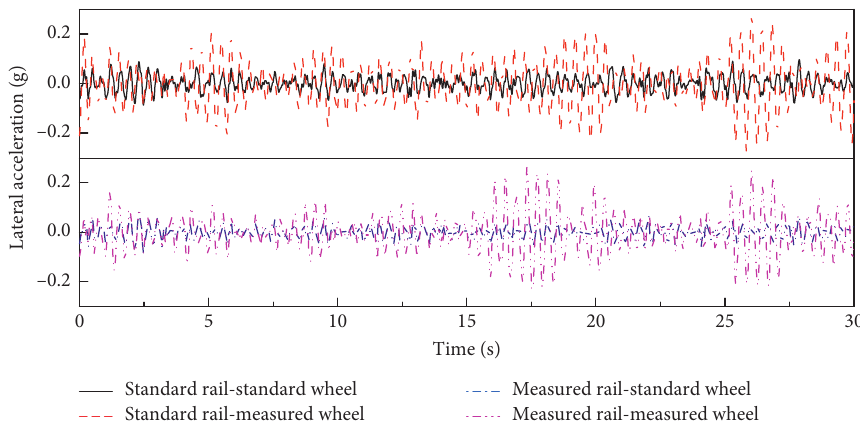
Figure 14: Time history comparison of vehicle body transverse vibration